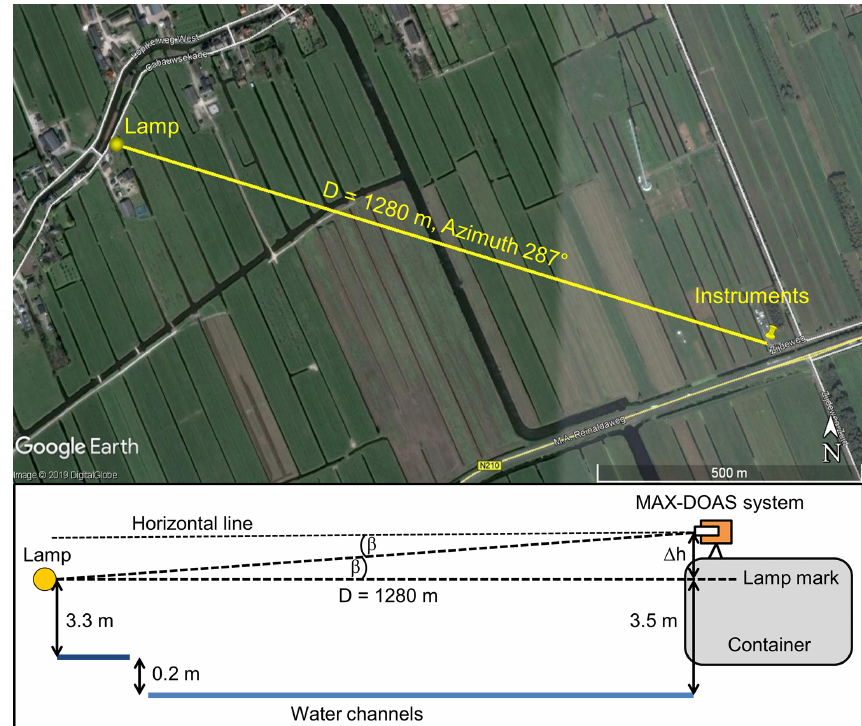
Figure 3. Upper panel: map indicating the position of both the lamp and the MAX-DOAS instruments. Lower panel: sketch of the setup for the far-lamp measurements during the CINDI-2 campaign. Note that the lamp is placed below the height of the telescope, and therefore a slightly negative elevation of − 0 . 05 ◦ is expected (see